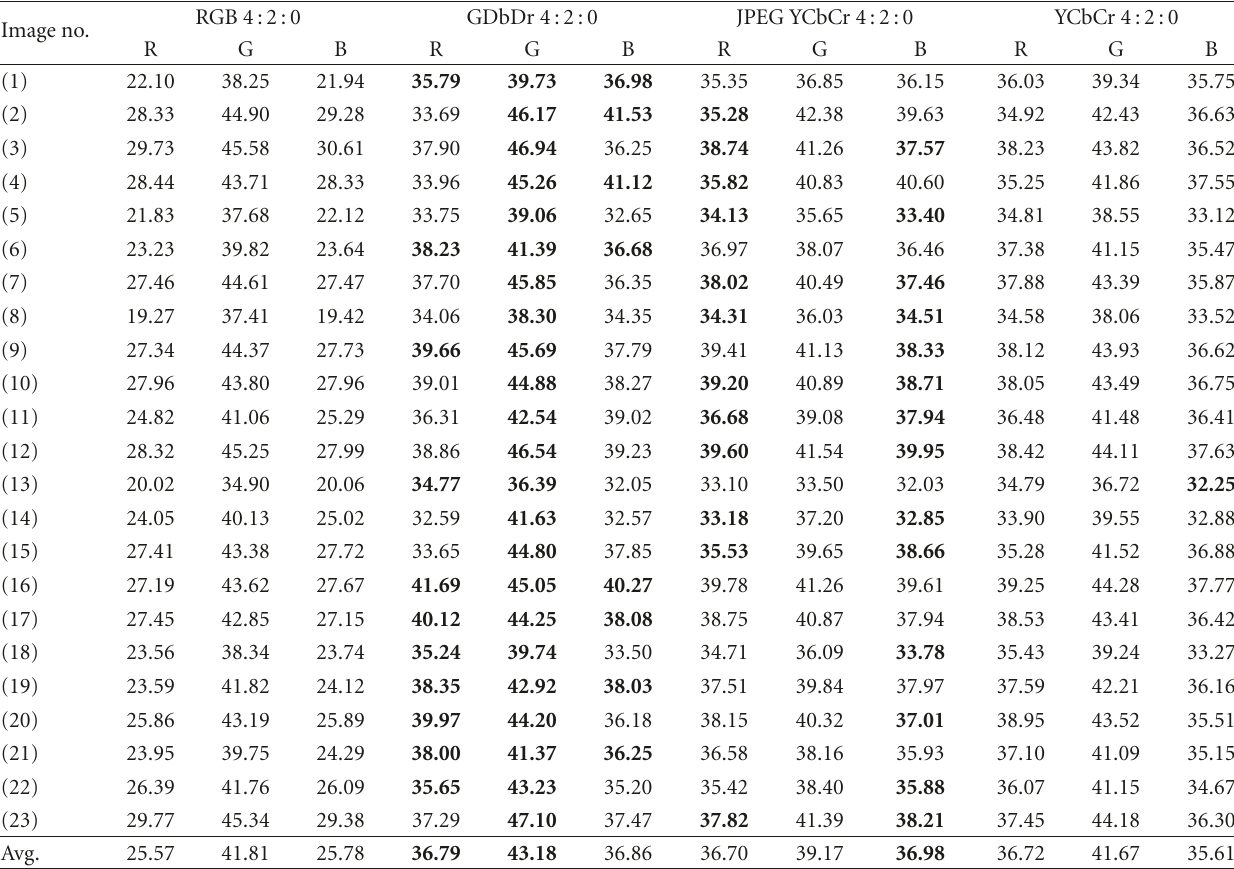
Table 7: PSNR (db) of 75% frame memory compression for 23 Images with various color transformations. Image